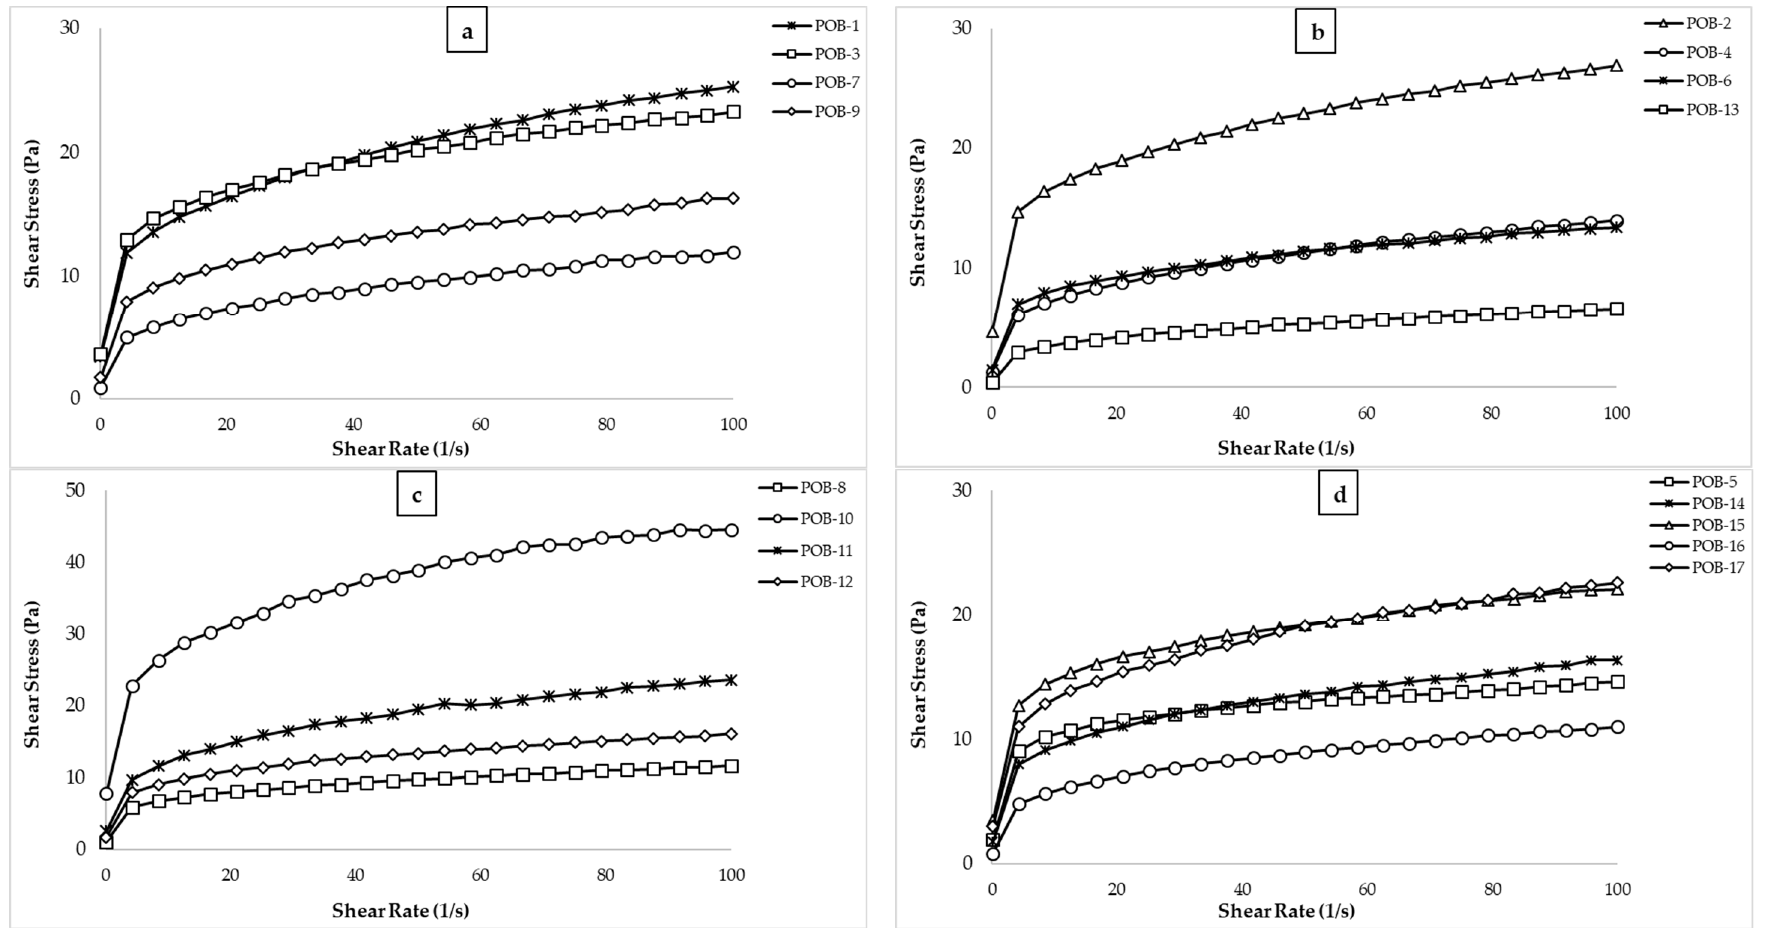
Figure 1. Steady shear rheological properties of the salad dressing samples contained with POB (POB: cold-pressed pumpkin seed oil by-product). ( a ): POB-1, 3, 7, & 9; ( b ): POB-2, 4, 6, & 13; ( c ): POB-8, 10, 11, & 12; ( d ): POB-5, 14, 16, & 17.